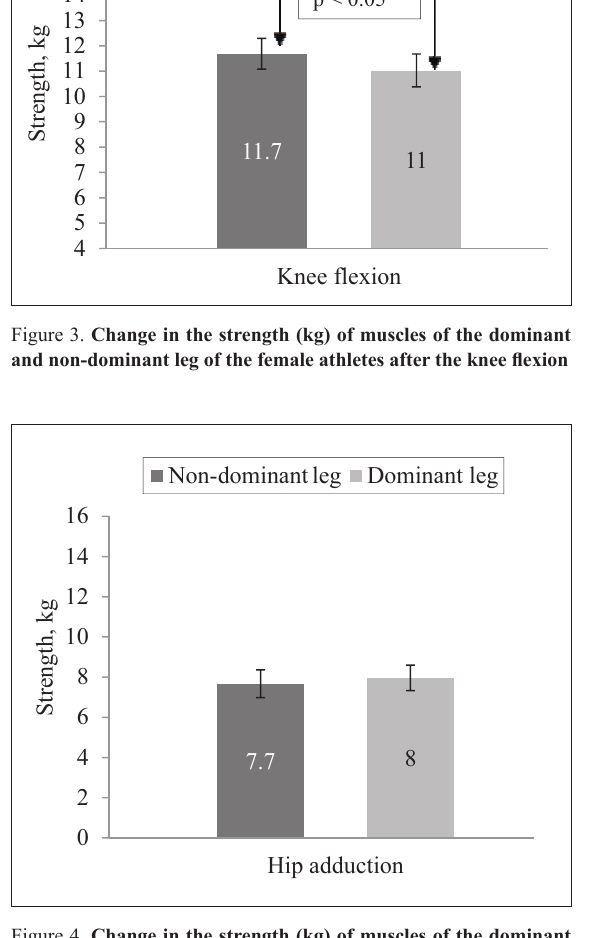
Figure 4. Change in the strength (kg) of muscles of the dominant and non-dominant leg of the female athletes after the hip adduction